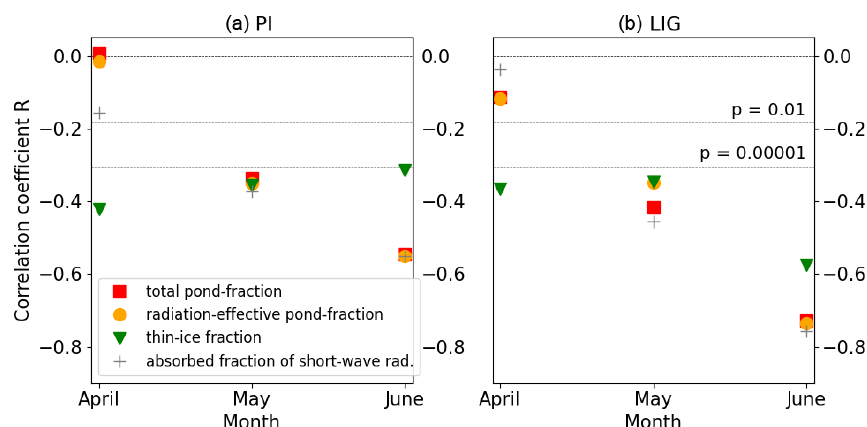
Figure 12. Correlation between the spring melt pond fraction (MPF) of sea-ice area (SIA) and autumn SIA for (a) PI and (b) LIG. For both panels (a) and (b) , 200 years of monthly model data were used over the region 70–90 ◦ N. Pearson’s correlation coefficient R was calculated between mean August–October SIA and, in each of April, May, and June of the same year, (1) the mean pond fraction of sea-ice area (red), (2) the radiation-effective pond fraction (gold), (3) the mean thin-ice fraction of ice area (green), and (4) the mean fraction of incident short- wave radiation absorbed (grey). A statistically significant correlation is defined as correlation with p < 0.05; dotted lines delimit regions of very high statistical significance with p < 0.01 and p <